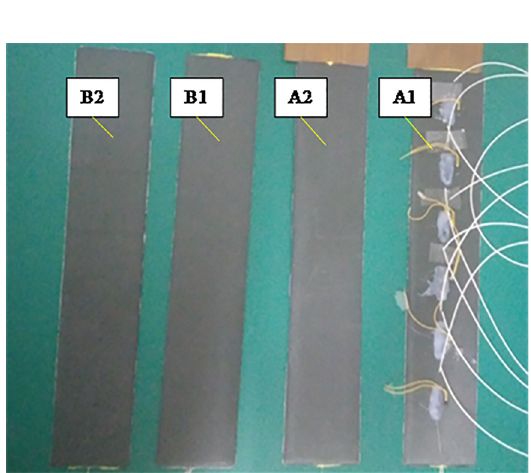
Figure 4. Prepared Test Piece of Equal Thickness and Variable Thickness